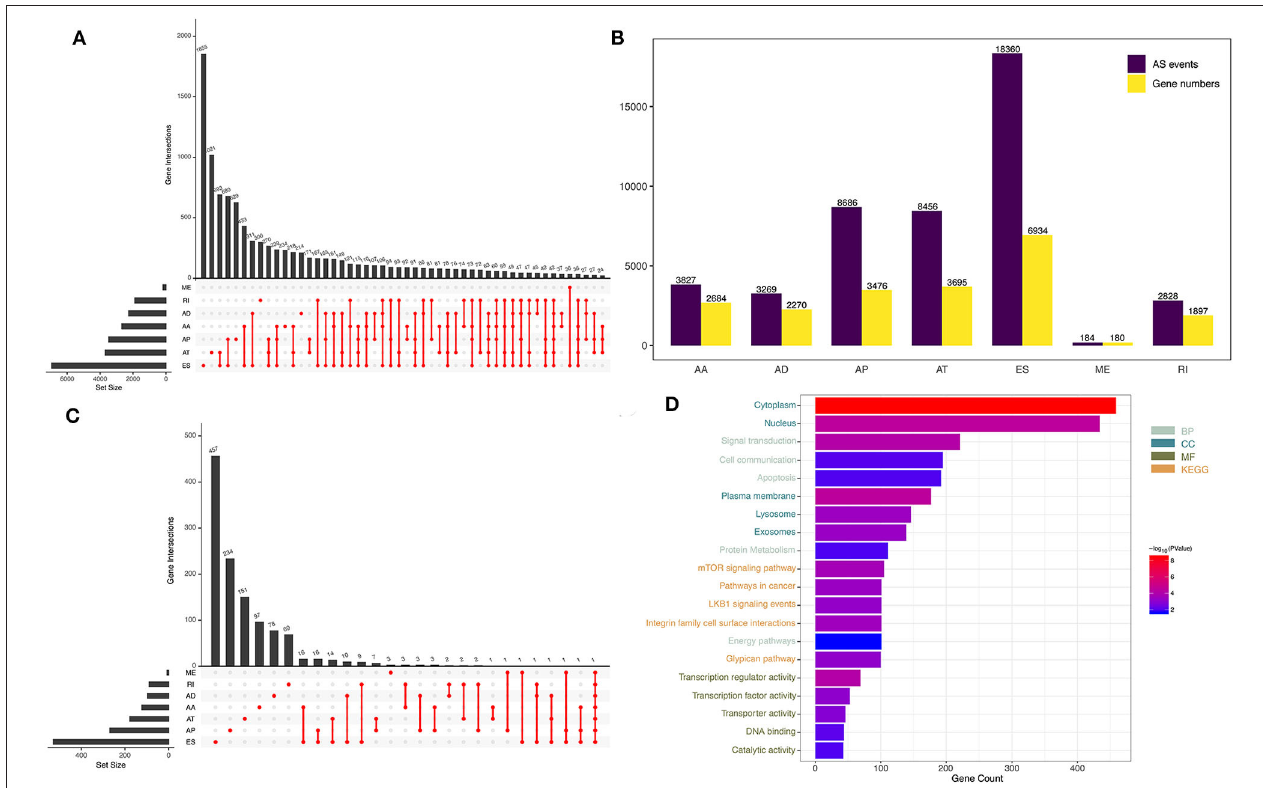
FIGURE 1 | Overview of AS events in GBM patients. (A) UpSet plot of the seven types of AS events. (B) The source genes of the seven types of AS events. (C) The seven types of AS events and their association with survival, shown as an UpSet plot. (D) Functional enrichment analysis of the source genes of prognostic AS events.